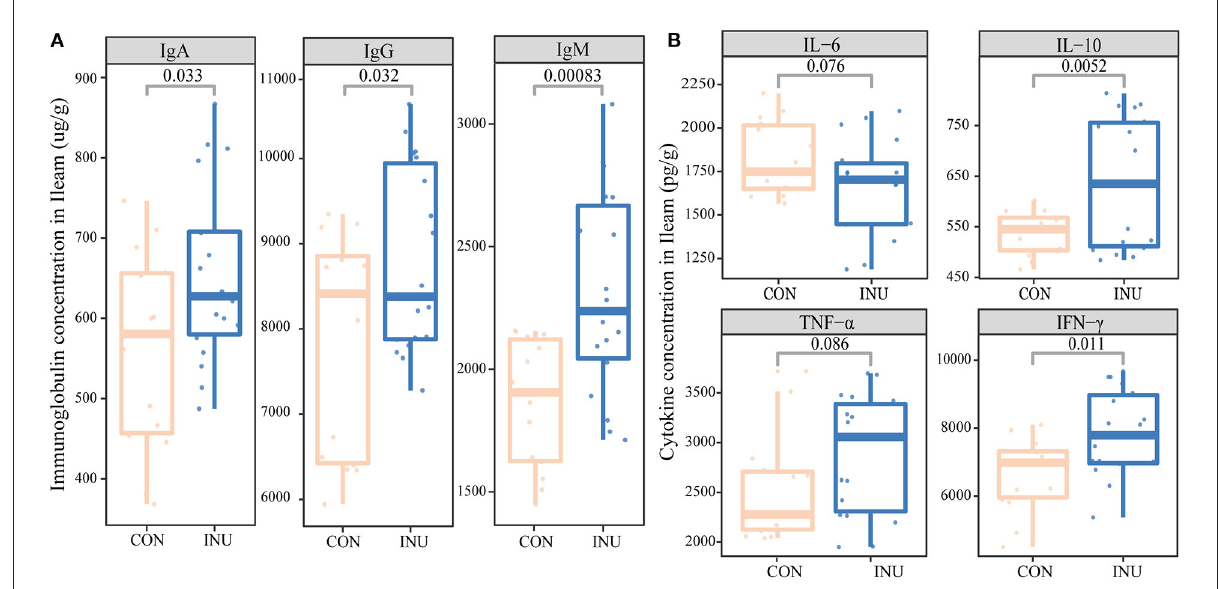
FIGURE5 The changes of local immunoglobulins and cytokines in ileum tissue of kids fed maize-grain based diet (CON) or low-carbon high inulin diet (INU). (A) is the immunoglobulins (IgA, IgG and IgM), (B) is the inflammatory cytokins (TNF- α , INF- γ , IL-6, and